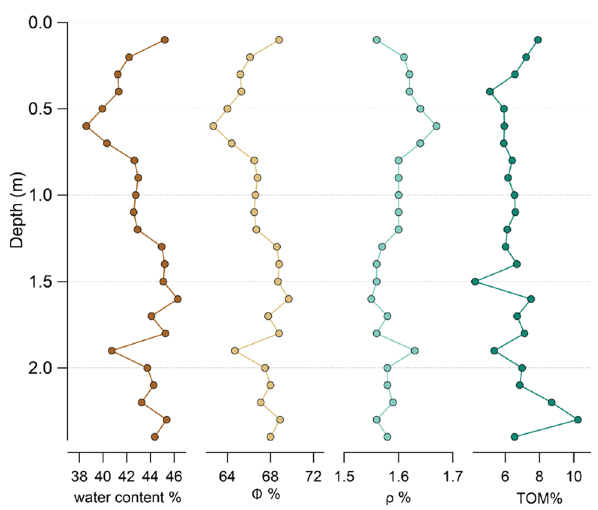
Figure 4. Physical–chemical parameters distribution in marine sediments (corer